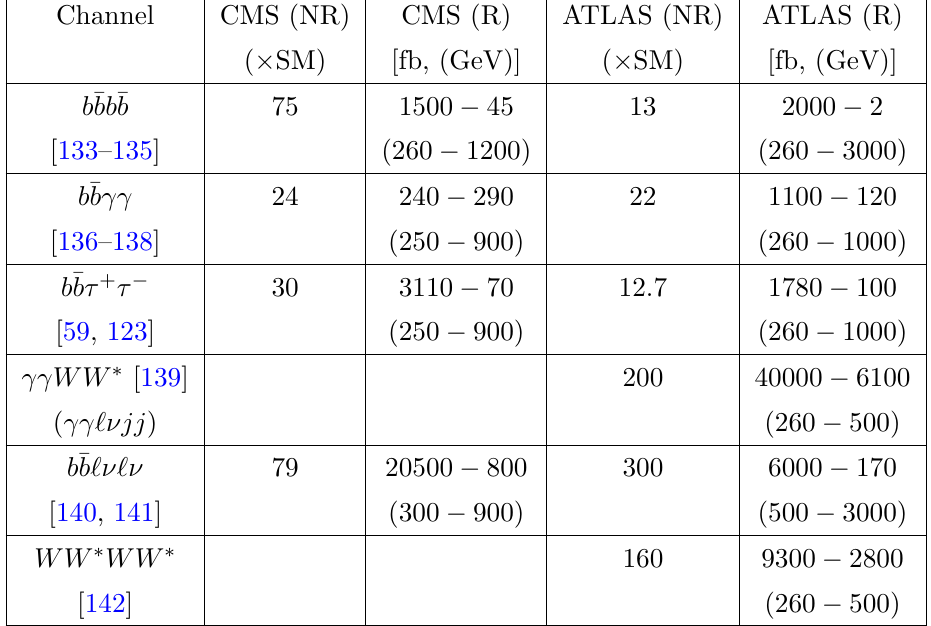
Table 1 . Bounds obtained on the di-Higgs cross-sections (in fb) from CMS and ATLAS studies dedicated to the search for non-resonant (NR) and resonant (R) double Higgs production in various channels. The numbers in brackets show the range of the heavy scalar mass considered in that particular